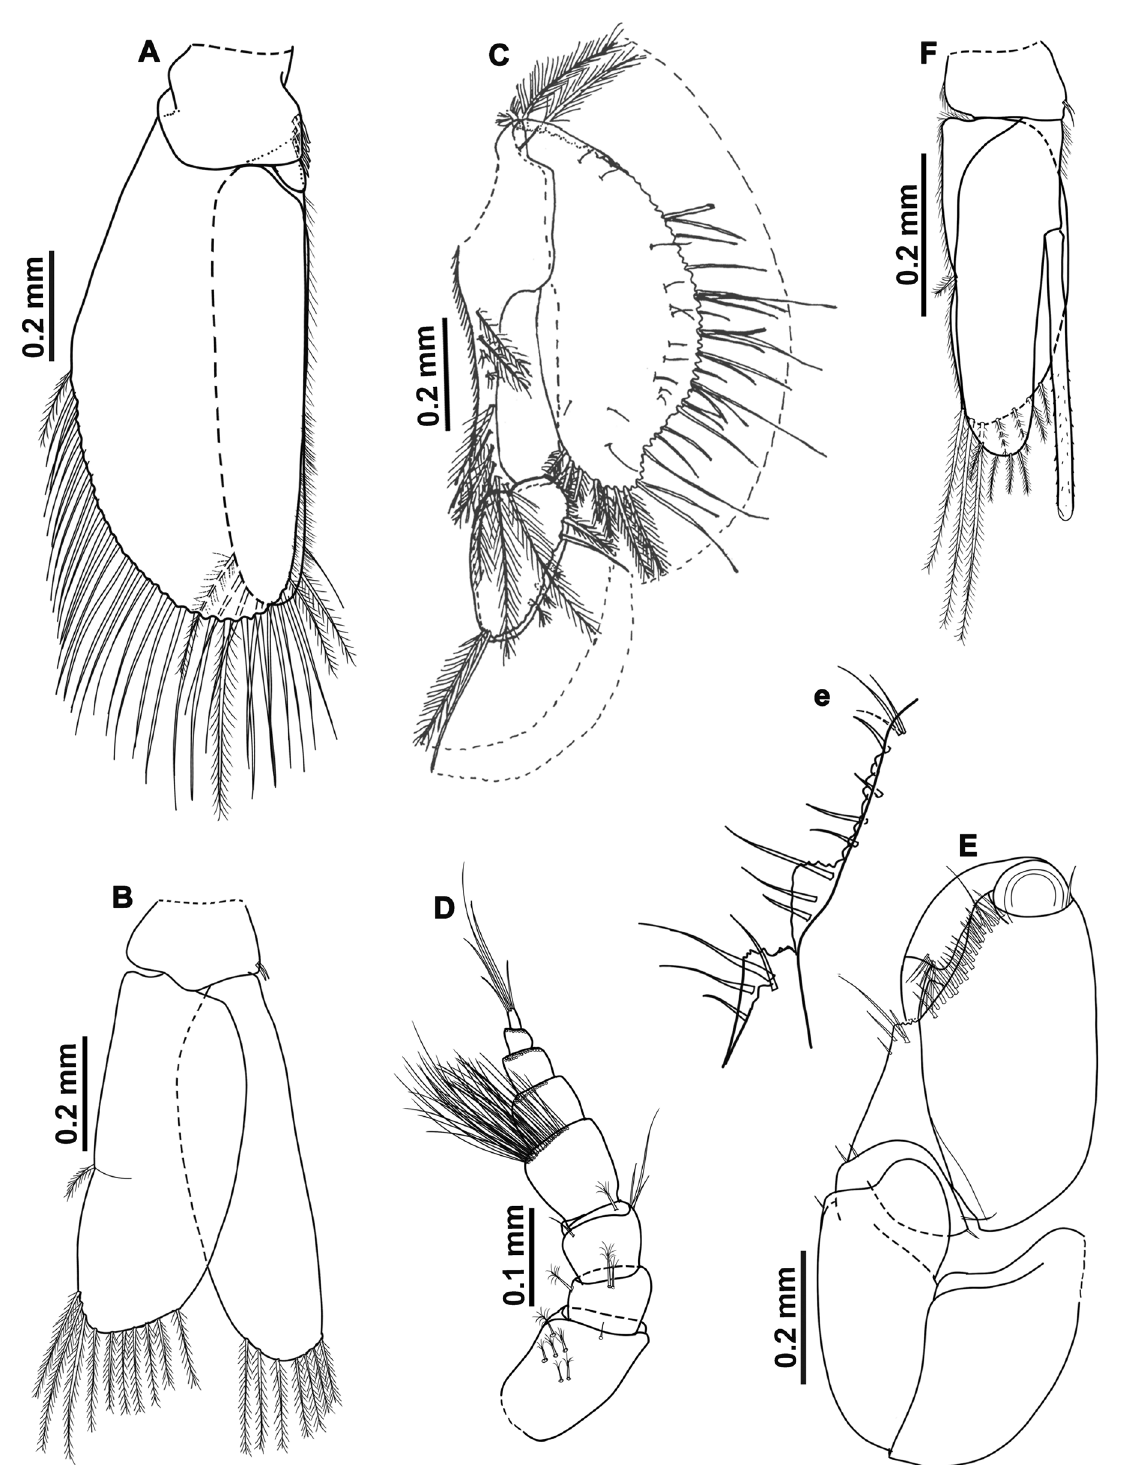
Fig. 10. Mesanthura antenniformis sp. nov. A–C . Holotype, ♀ (ovigerous), 8 mm, Oaxaca, Puerto Ángel, Estacahuite Beach (UMAR-PERA 542). A . Pleopod 1. B . Pleopod 2. C . Uropod. D–F . Paratype, ♂, 4.1 mm (UMAR-PERA 543). D . Antennule. E . Pereopod 1 and detail of the palm (e). F . Pleopod